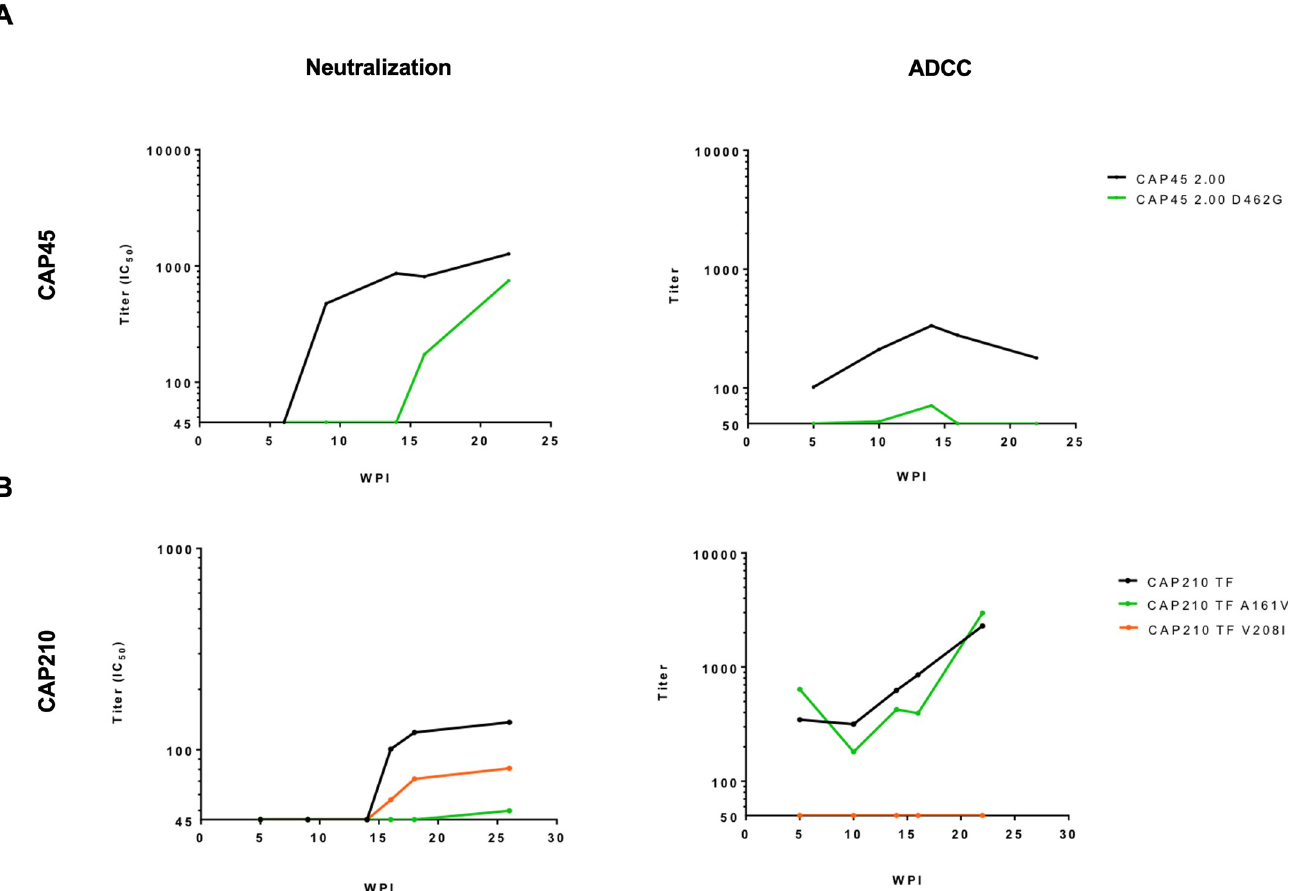
Fig 5. Escape from both neutralization and ADCC responses in two CAPRISA 002 participants. Neutralizing and ADCC responses were evaluated against wildtype and mutant viruses where putative ADCC or nAbs escape mutations were introduced into the autologous CAP45 or CAP210 T/F Env-IMCs. The impact of each mutation on sensitivity to autologous nAb and ADCC responses was then tested using longitudinal plasma. (A) Effect of the D462G mutation on neutralization and ADCC responses in CAP45; (B) Effect was A161V and V208I mutations on nAb and ADCC responses. Points on ADCC and neutralisation plots indicate the mean of � three independent